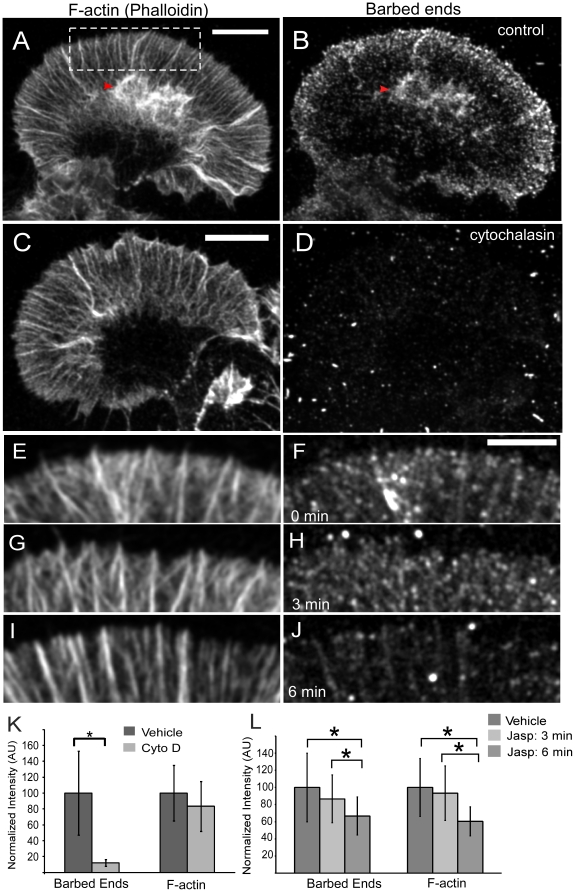
Jasplakinolide treatment reduces barbed end density at the leading edge.Growth cones were dual-labeled with TRITC-phalloidin to show total filamentous actin (A, C, E, G, I) and Alexa 488 g-actin, which incorporates at barbed ends (B, D, F, H, J). (A–B) Barbed ends are concentrated at the leading edge of the growth cone peripheral domain and with intrapodia (red arrowhead) under control conditions. G-actin incorporation is eliminated in the presence of 5 uM cytochalasin D (D&K), while total F-actin is unaffected (C&K), demonstrating the specificity of this labeling procedure for uncapped barbed ends. 6 min treatment with jasplakinolide reduced barbed end density relative to control (L, compare J and F). After 6 min the change in barbed end density was significantly different from both control and 3 min time points (L, compare F&H vs J). A similar pattern was seen for total filamentous actin (L, compare E&G vs I). K) Control: 40 growth cones, CytoD: 32 growth cones. L) Control: 32 growth cones, Jasp: 39 growth cones, Jasp+bleb: 43 growth cones. Examples in E–J are regions similar in size to the dashed white box in A. Error bars are standard deviations. (*: significance level p<0.05 using a two sample Student's t test, unequal variance). Scale bars: A&C 10 µm; F 5 µm.